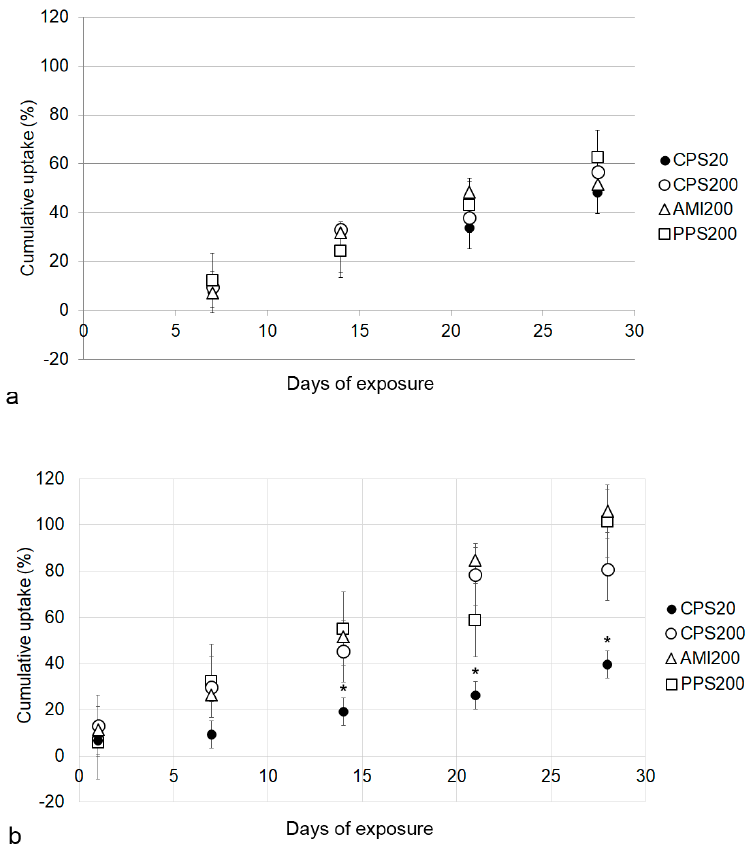
Figure 6. Uptake of polystyrene particles over 28 d by Calu-3 ( a ) and A549 ( b ) cells. The fluorescence of the administered dose is set as 100%. Significant differences are indicated by asterisks.